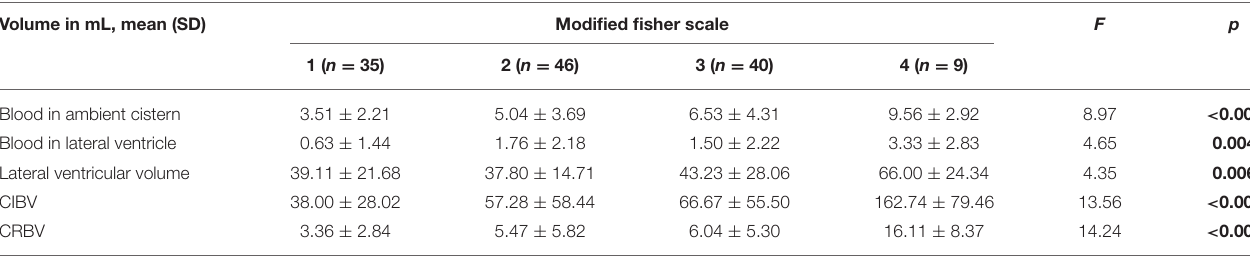
TABLE 3 | Analysis of variance results of varying degree of mFisher score. Volume in mL, mean